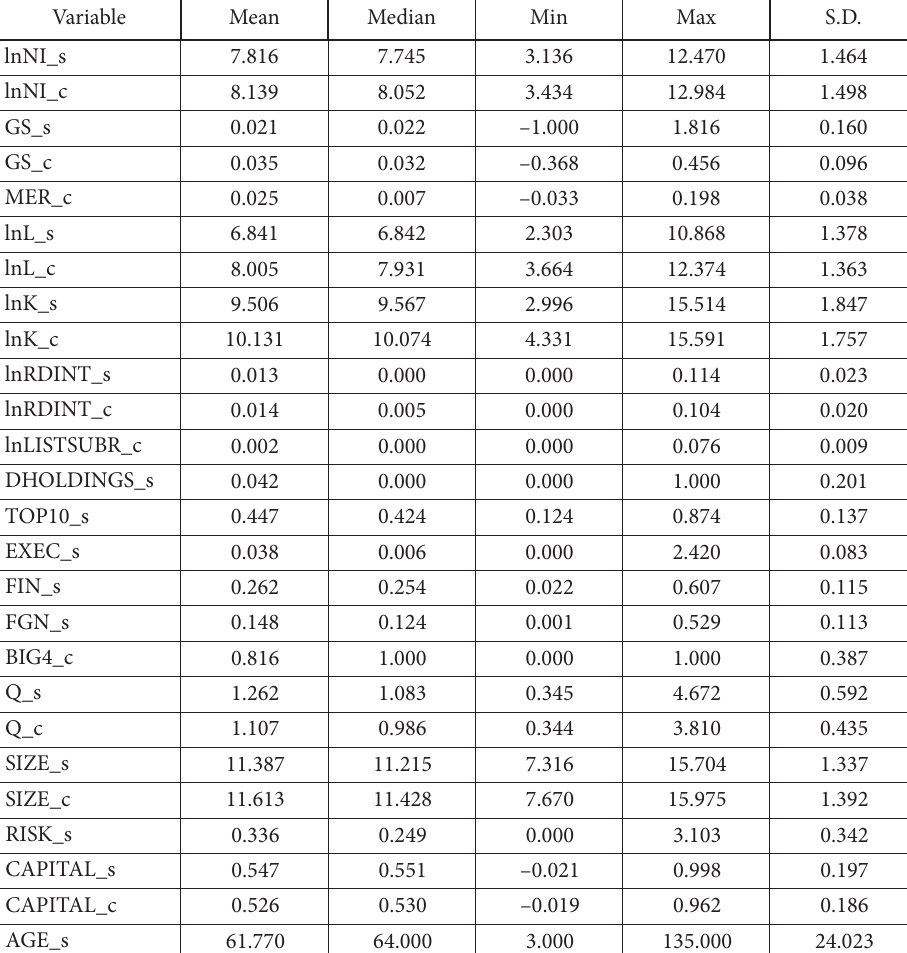
Table 2. Descriptive statistics (N = 10,315